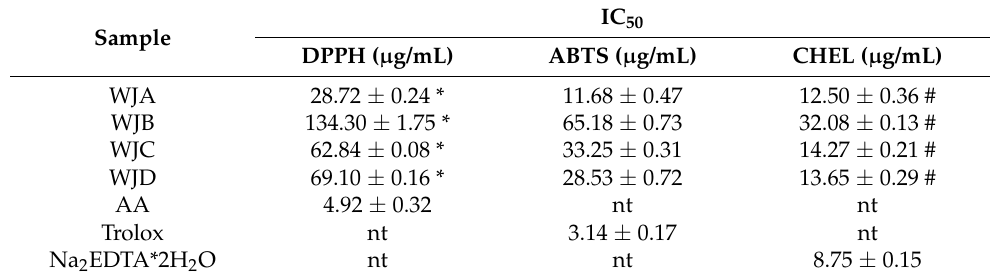
Table 3. The IC 50 values determined in the antioxidant tests. Data were expressed as the mean ± SD, n = 3. AA—ascorbic acid; Na 2 EDTA*2H 2 O—ethylenediaminetetraacetic acid, disodium dihydrate; nt—not tested. The flowers (WJA), roots (WJB), and leaves (annual—WJC and biennial—WJD) of E. japonicum . DPPH—2,2-diphenyl-1-picryl-hydrazyl radical; ABTS—2,2 (cid:48) -azino-bis-(3-ethyl- benzothiazole-6-sulfonic acid; CHEL—metal chelating activity. * Statistically significant